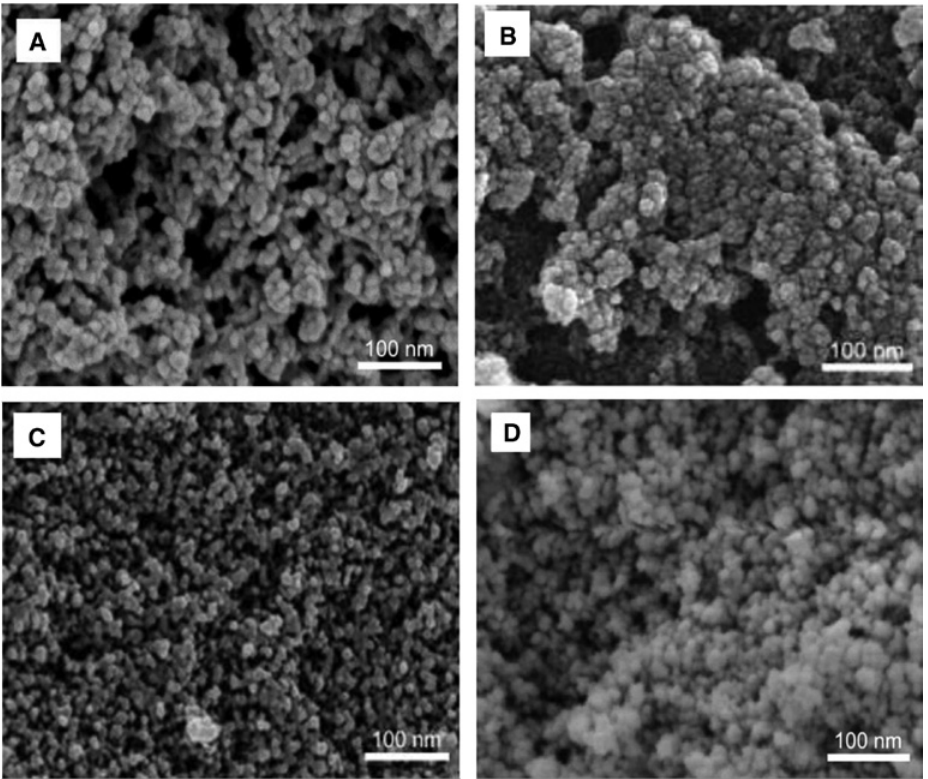
Figure 2: Scanning electron microscopy (SEM) images of (A) silica aerogel (SA), (B) SA/poly(methyl methacrylate) (PMMA), (C) SA-KH570/ PMMA and (D) SA-amino-capped polydivinylsiloxane